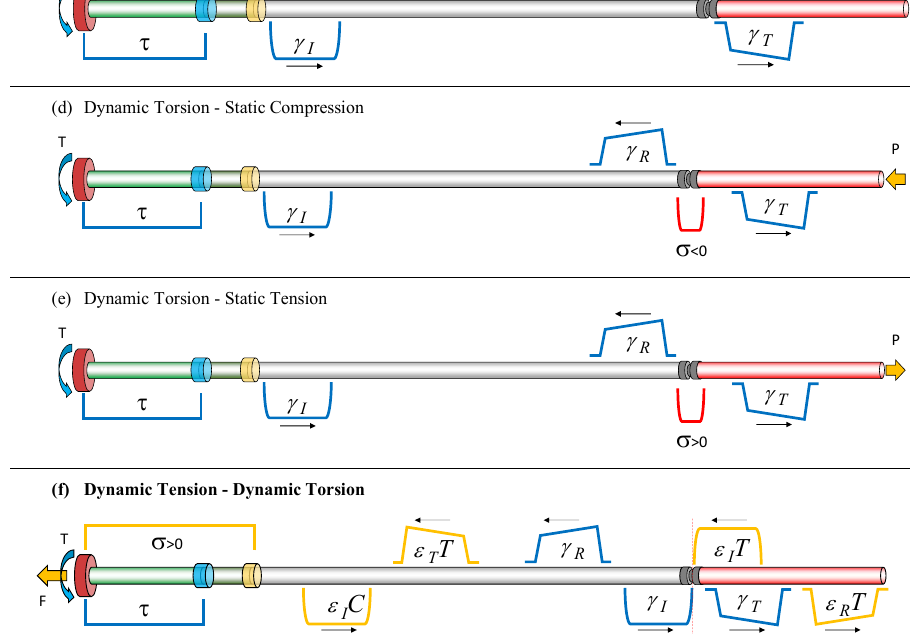
Fig. 3. Wave generation: schematic representation of direct tension-torsion apparatus; ε IC : compression incident wave, ε IT : tension incident wave, ε TT : tension transmitted wave, ε RT : tension reflected wave, γ I : torsional incident wave, γ T : torsional transmitted wave, γ R : torsional reflected